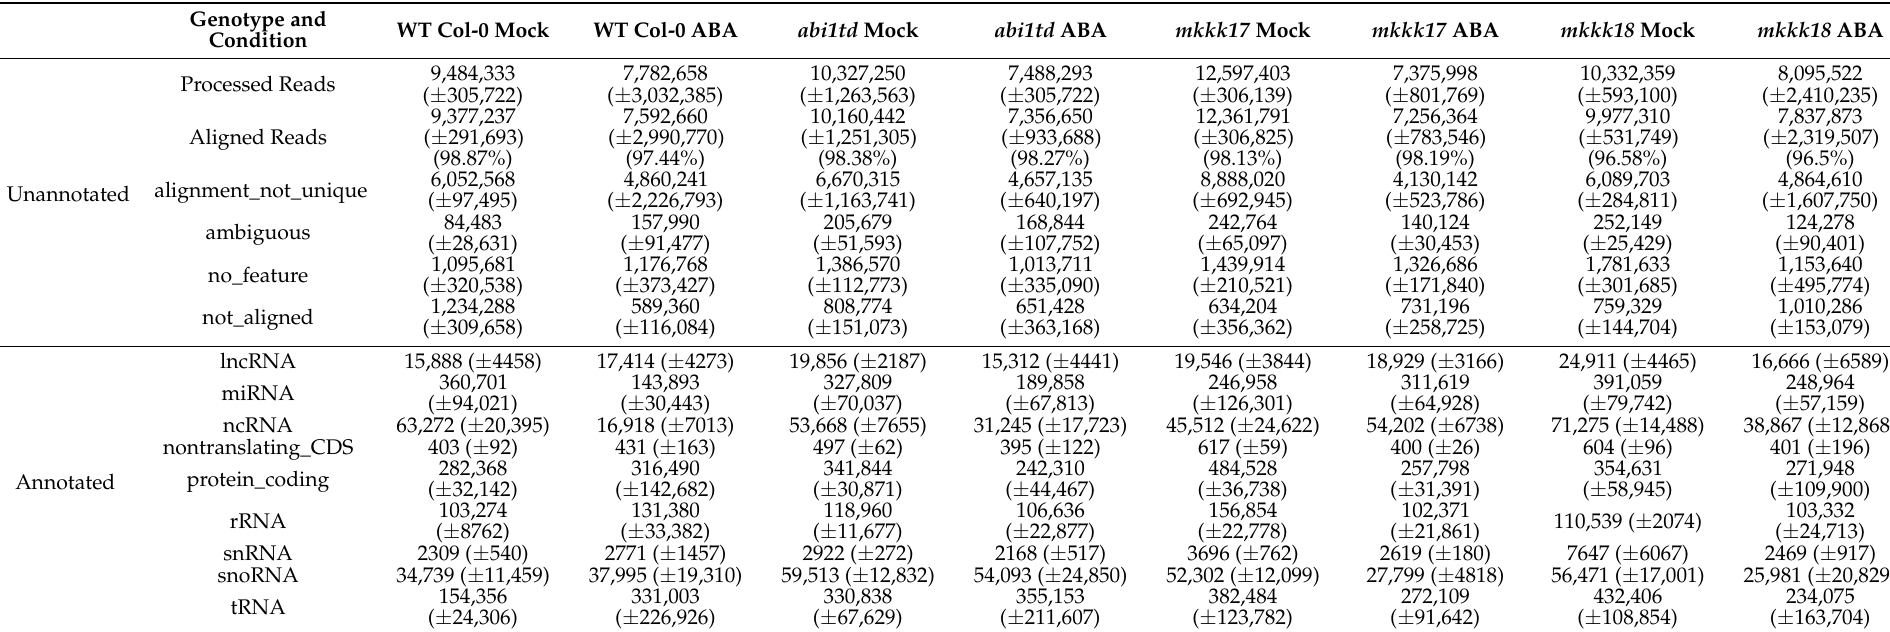
Table 1. Mapping of small RNA-seq reads to the Arabidopsis thaliana genome of all libraries of Arabidopsis WT Col-0, abi1td , mkkk17 , and mkkk18 mutants before (mock) or after four hours of 100 µ M ABA treatment (mock- and ABA-treated) in each of three biological replicates. Values with “ ± ” in “[]” show standard